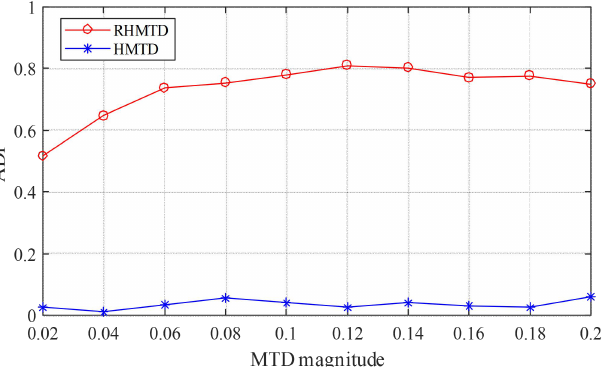
Figure 13. The ADP of RHMTD and HMTD against the model-based alert attacker under different MTD magnitudes.